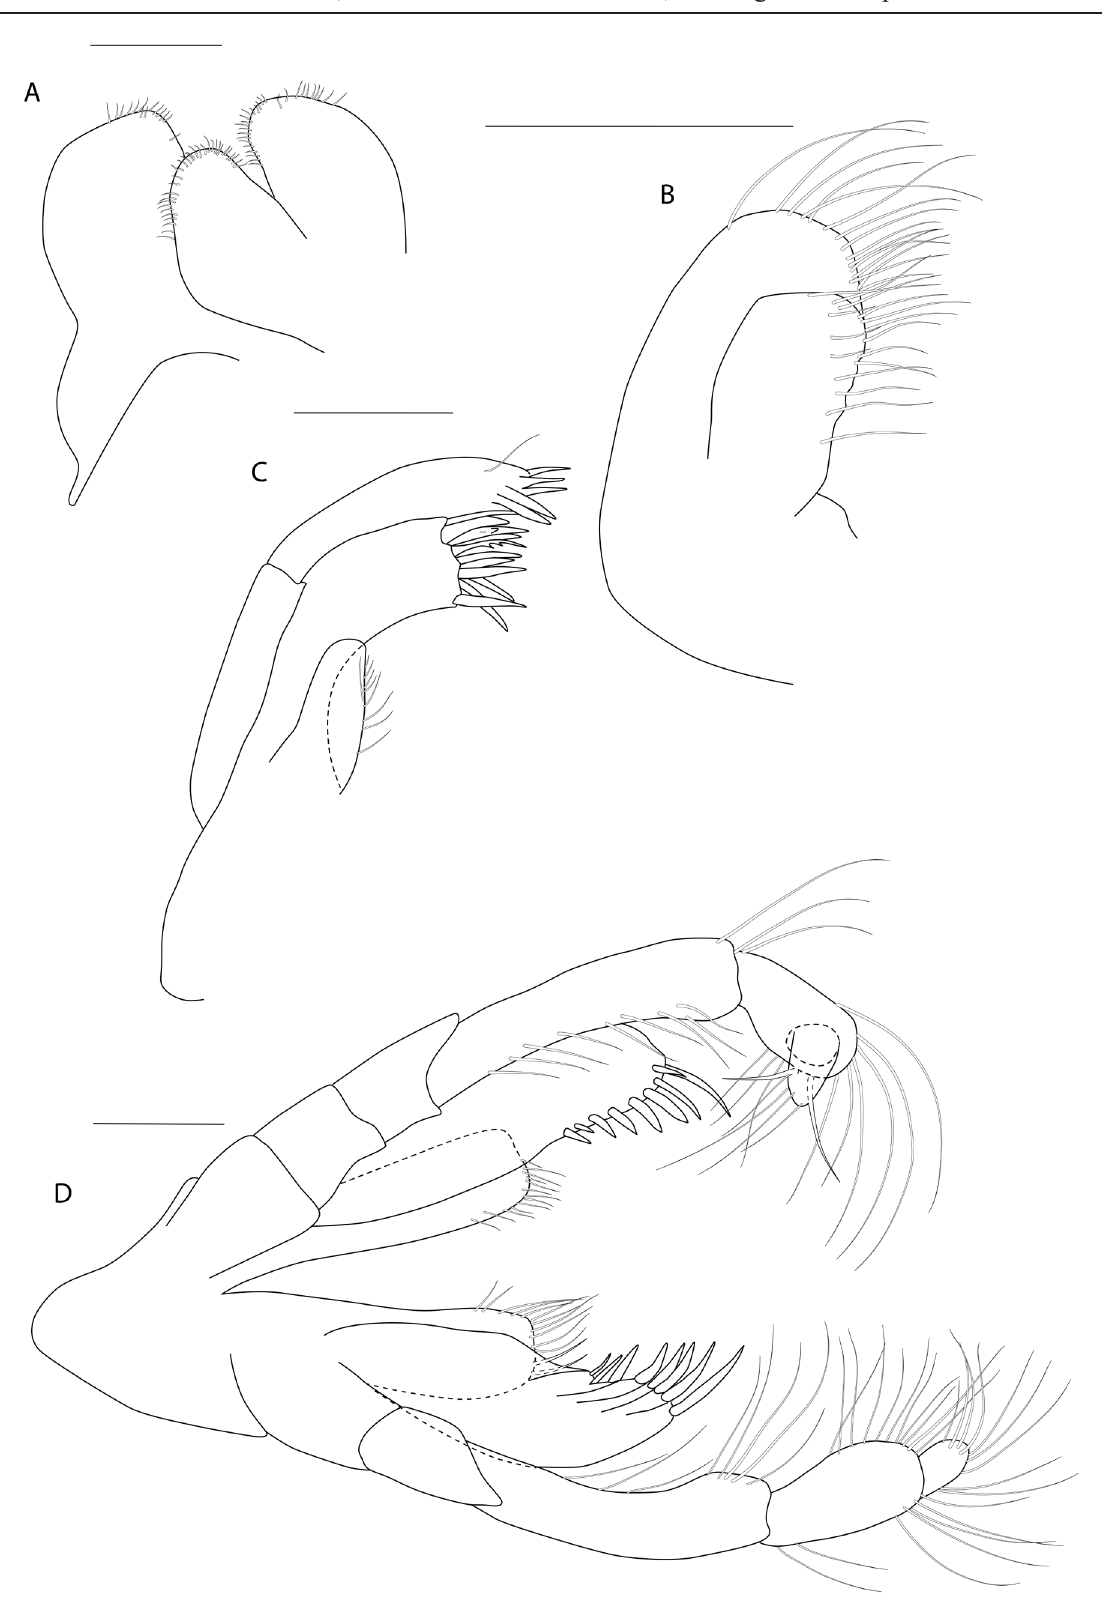
Fig. 4. Bryoconversor tutus gen. et sp. nov., holotype, ♀, NIWA 88918, 1.72 mm long. A . Hypopharynx. B . Maxilla 2. C . Maxilla 1. D . Maxilliped. Scale bars = 100 μ